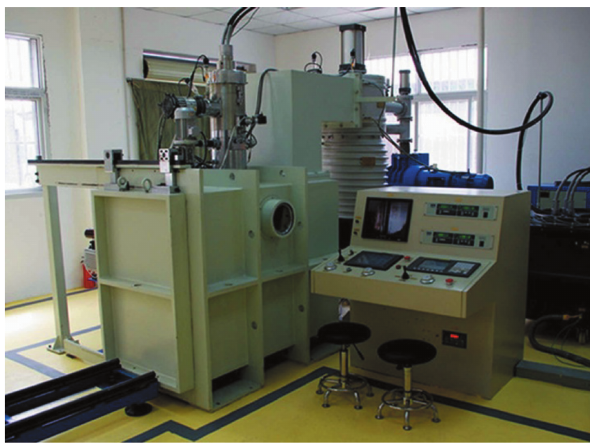
Figure 1: EBW equipment used in experiments.